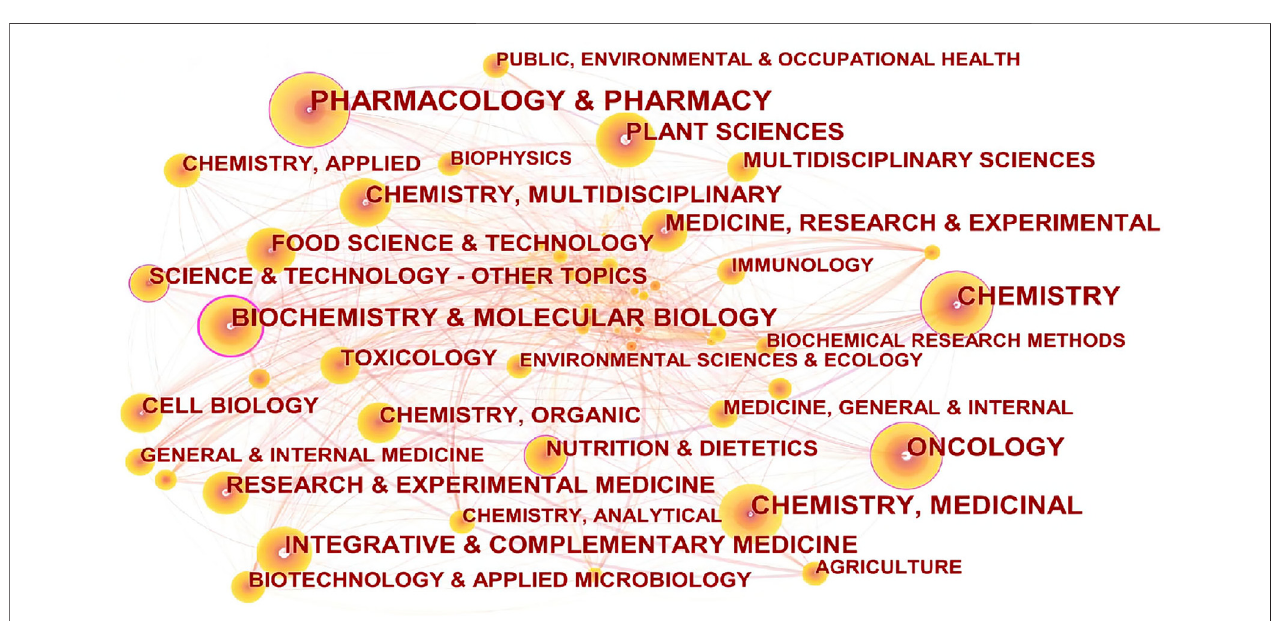
FIGURE 10 | Subject co-occurrence network of scienti fi c articles on anticancer natural products. Pharmacology and pharmacy has the highest co-occurrence frequency in the network; biochemistry and molecular biology has the highest centrality. The node size represents the number of articles in the subject area, the lines betweenthenodesrepresenttheco-occurrencerelationship,andthethicknessofthelinesrepresentstheco-occurrencestrength.Thelargerthenode,thegreateristhe number of articles. Nodes with centrality greater than 0.1 are marked with a purple outer circle.